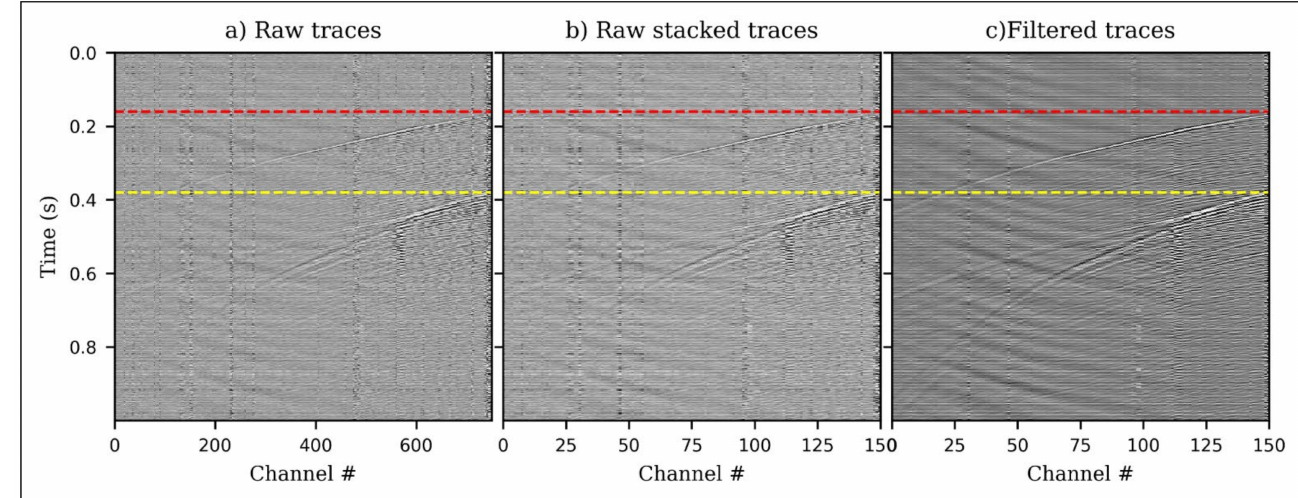
Figure 1. Sample detected event ( a ) raw DAS traces before stacking ( b ) raw traces after stacking ( c ) same traces after 300 Hz minimum phase low-pass and 2D spatial filtering. P arrival (red) and S arrival (yellow). Table 1. Range of parameters used to generate the velocity models. Thomsen anisotropic parameters [42] of ε = 0.51, γ = 0.36, and δ = 0.25 were taken to be constant throughout the layers. Parameter v p0 (m/s) v s0 (m/s) ρ (kg/m 3 ) Depth (m)